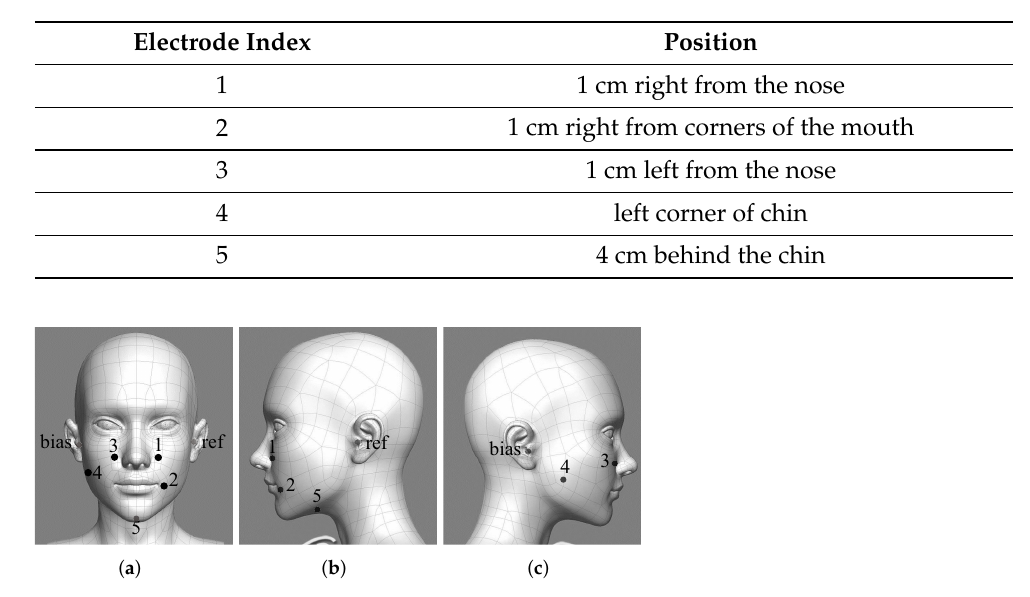
Table 1. Electrode Location Details.